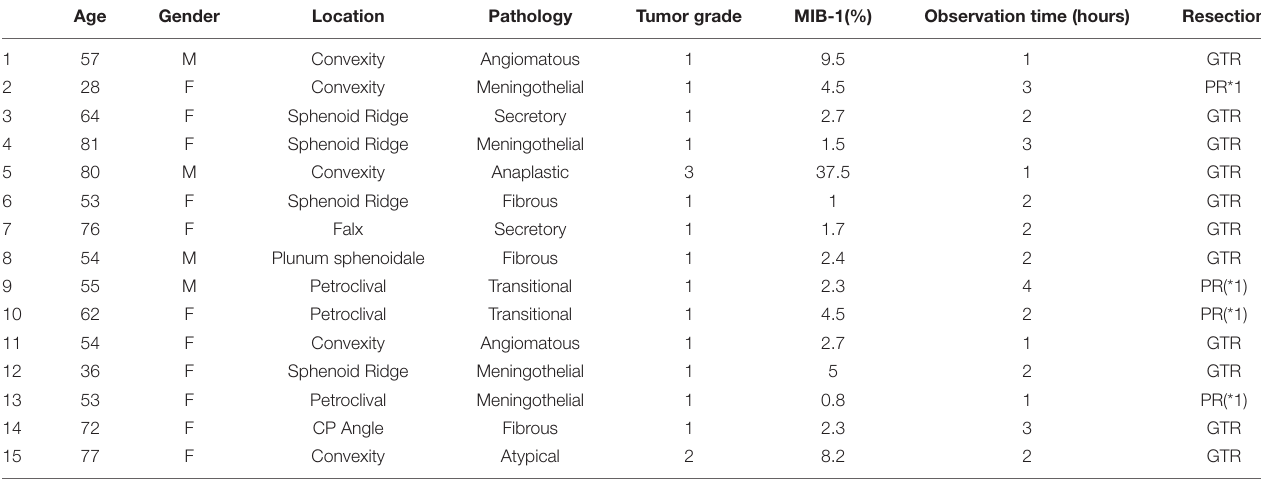
TABLE 1 | Data of 15 patients with intracranial meningioma, including age, gender, tumor location, pathology, tumor grade, MIB-1(%), time from ICG injection (hours), resection rate. Age